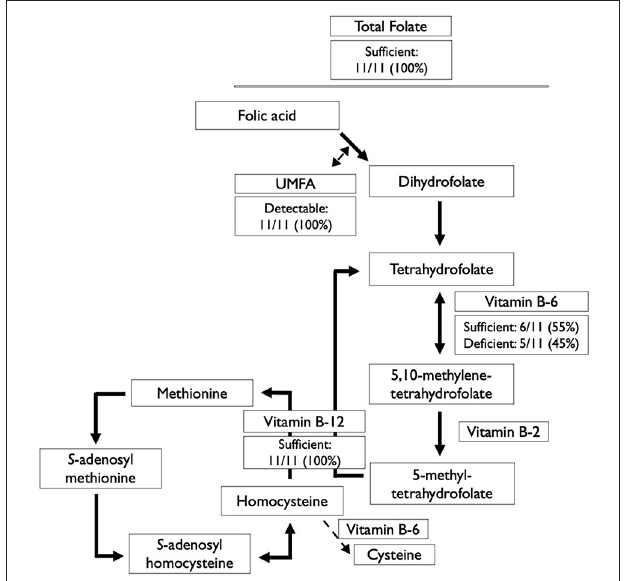
FIGURE 1 | Serum/plasma status of B-vitamins involved in the folate and methionine cycles among 11 Canadian children with sickle cell disease. UMFA, unmetabolized folic